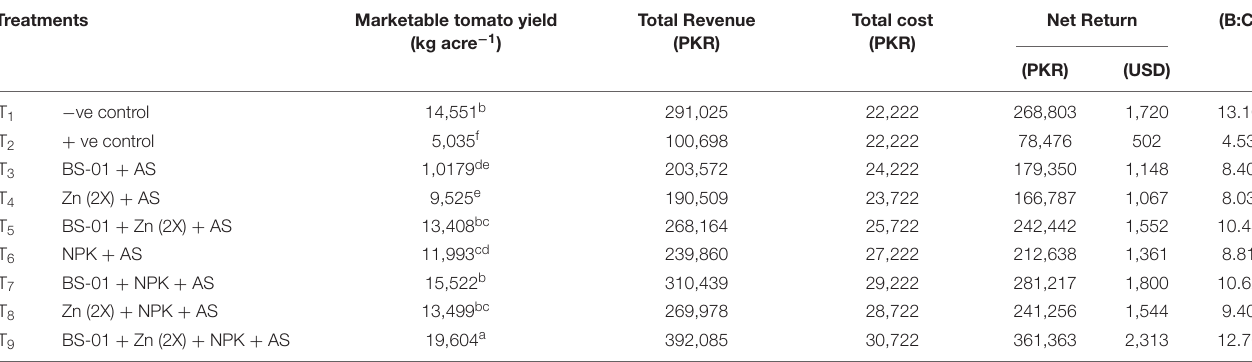
TABLE 8 | Effect of Bacillus subtilis (BS-01) and mineral nutrients [Zn (2X: 10 kg acre − 1 ) and NPK (64:46:50 kg acre − 1 )] on the marketable tomato yield (kg acre − 1 ), total revenue (TC), total cost (TC), net return (NR), and benefit-cost ratio (B:C) of tomato plants inoculated with Alternaria solani (AS) in the field.